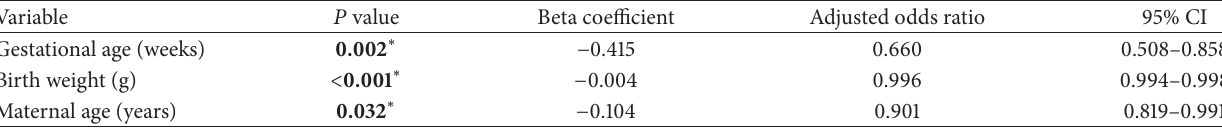
Table 2: Multivariate logistic regression analyses of risk factors for developing any stage of ROP in gestational age < 33 weeks infants. Variable 𝑃